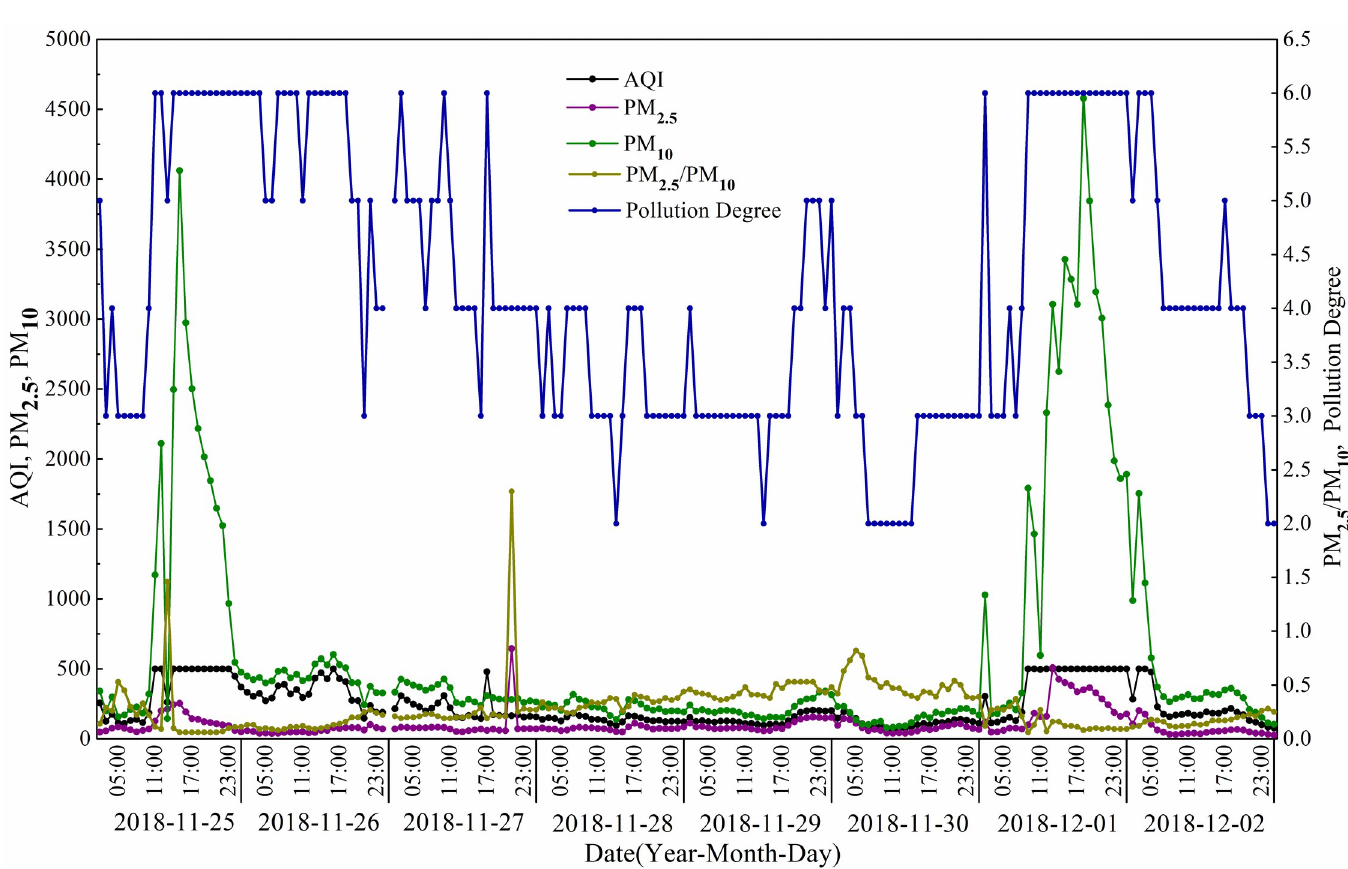
Fig 8. Variations of AQI and concentrations of PM 2.5 and PM 10 during the two air pollution events emerged from November 25 th to December 2 nd , 2018.